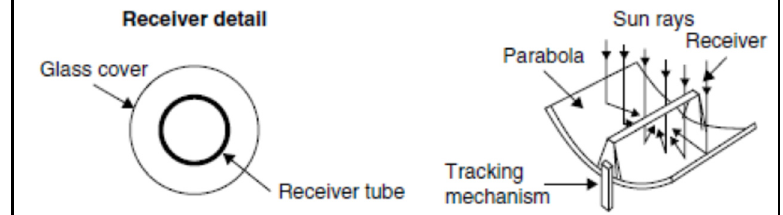
Figure 2. Schematic diagram of a parabolic trough collector.